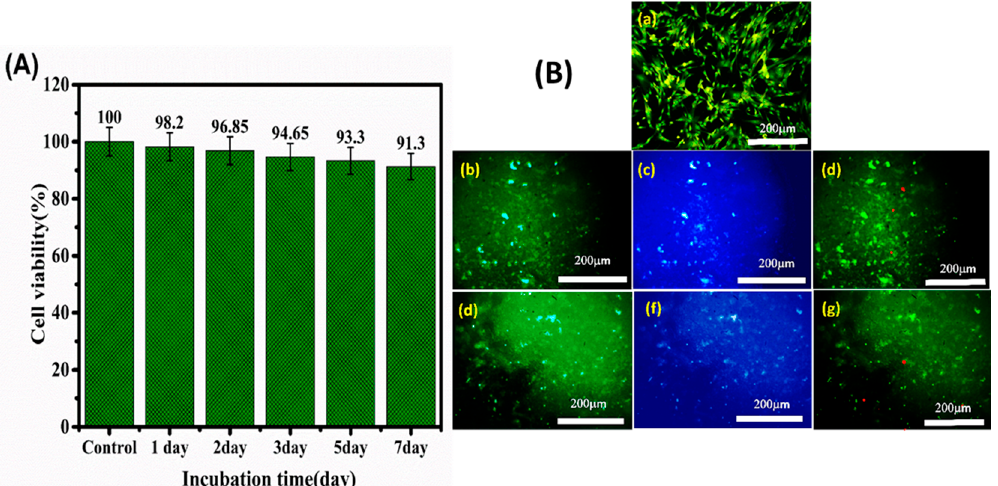
Figure 8. In vitro experiments related to cell survival and migration into the scaffolds. ( A ) Viability of H9C2 cells encapsulated within hydrogels for various incubation times. ( B ) Fluorescence microscopy images of the control test with H9C2 cells. (a) H9C2 cells encapsulated within hydrogels for various incubation times after (b–d) 3 days and (e–g) 7 days in vitro culturing, with AO/PI staining and DAPI/PI staining where green indicates live cells and the red stain indicates dead cells. Scale bars: 200 µm.